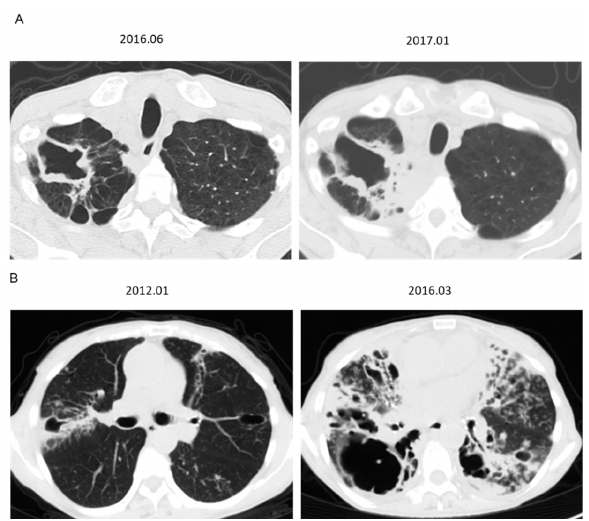
Figure 3. Serial computed tomography scans of patients with cavitary Mycobacterium avium complex pulmonary disease (MAC-PD) before and after diagnosis of chronic pulmonary aspergillosis (CPA). ( A ) Left: at the time of MAC-PD diagnosis (fibrocavitary form). Aspergillus galactomannan antigen 0.3, β -D glucan 8.8. Right: at the time of CPA diagnosis. Aspergillus galactomannan antigen 0.4, Aspergillus precipitating antibody-positive, β -D glucan 18.8 pg/mL, and isolation of A. fumigatus from sputum culture. ( B ) Left: at the time of MAC-PD diagnosis (cavitary nodular bronchiectasis). Aspergillus galactomannan antigen 0.2, β -D glucan 7.5. Right: at the time of CPA diagnosis.